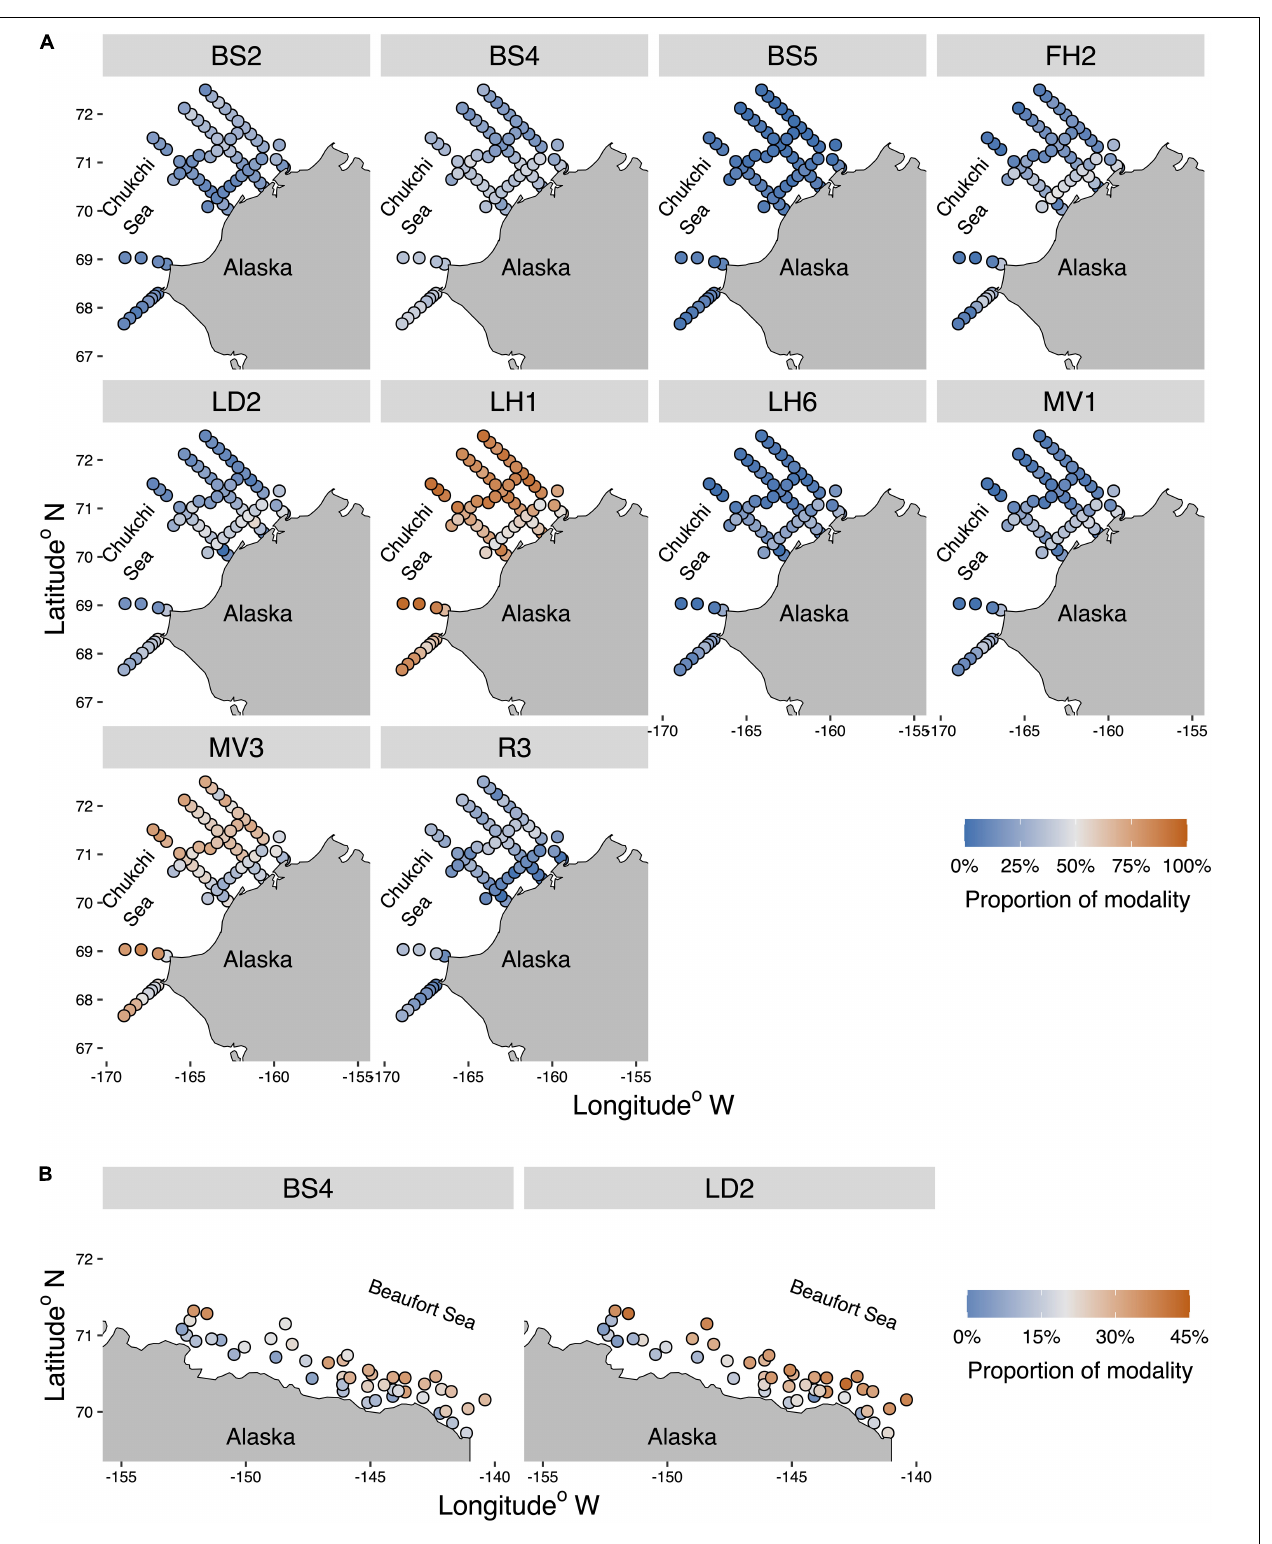
FIGURE 5 | Spatial representation of the significant modalities with absolute Pearson correlations > 0.15 for the first axis of the RLQ plot in the Chukchi Sea (A) and modalities with absolute Pearson correlations > 0.1 for the first axis of the RLQ plot in the Beaufort Sea (B) (see Figure 4 ). Pearson correlation cutoff levels were chosen based on the highest relative correlations on the first axis for the RLQ among all traits for each shelf. The full suite of spatial representations for all modalities in both seas is shown in Supplementary Figure 3 .